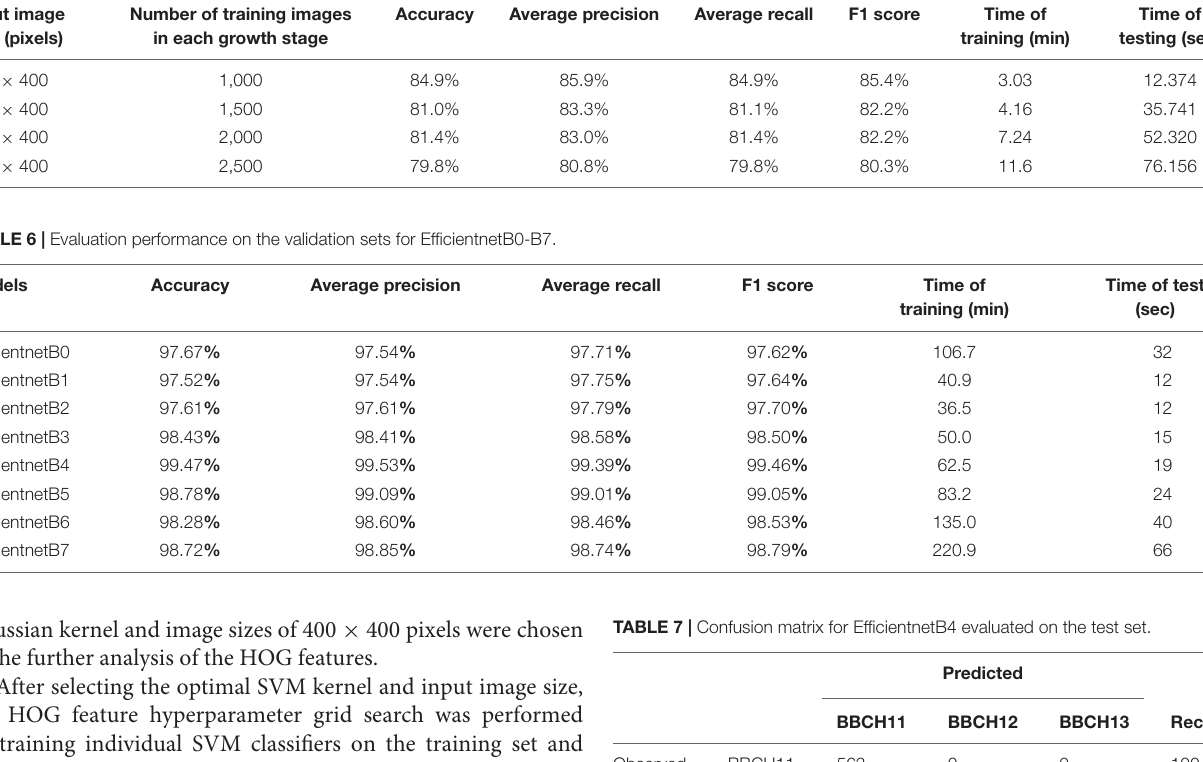
TABLE 5 | Evaluation performance on test sets for HOG-SVM classifiers with different numbers of training images in each growth stage. Input image size (pixels)